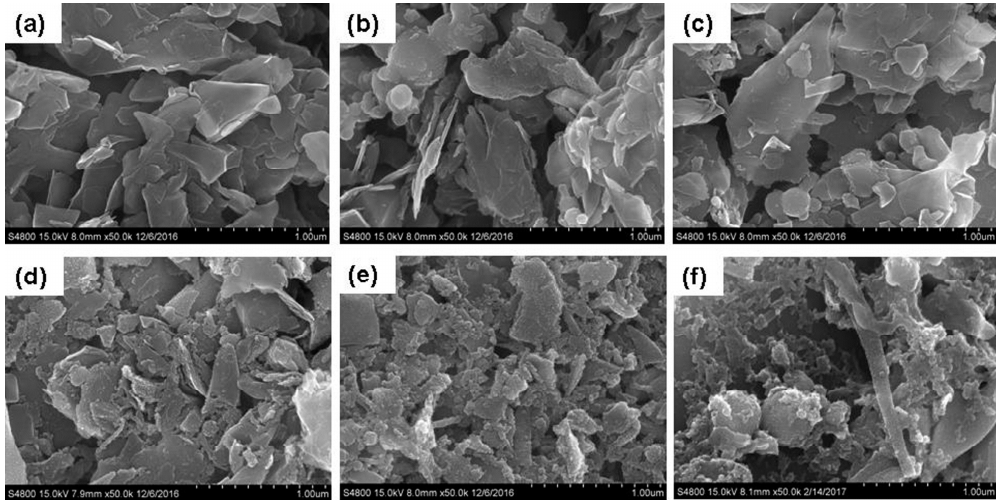
Figure 3. Field-emission scanning electron microscope (FESEM) image of the MNCBMs: ( a ) graphite powder (GP), ( b ) 0.5 MPa, ( c ) 1.0 MPa, ( d ) 1.5 MPa, ( e ) 2.0 MPa, and ( f ) 2.5 MPa.